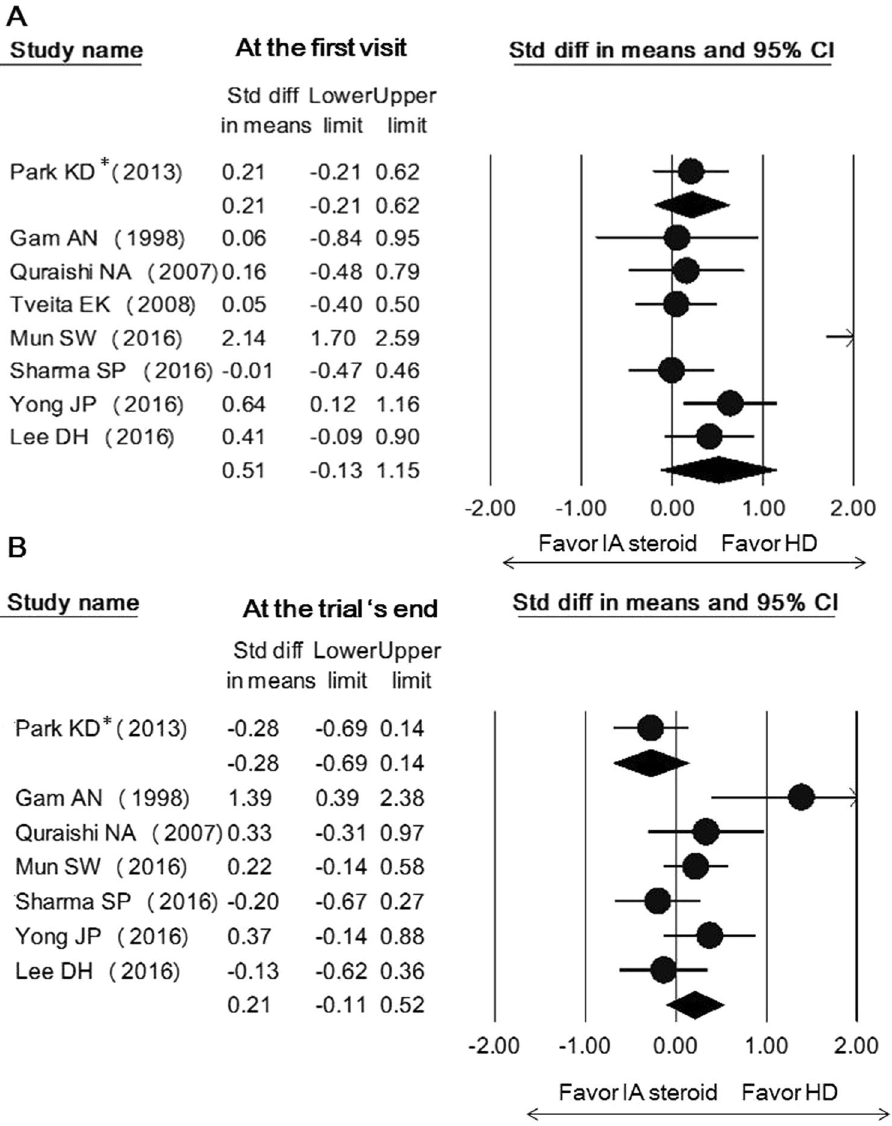
Figure 3. Forest plot of standardized mean differences of shoulder function improvement comparing hydrodilatation and intra-articular corticosteroid injection early following intervention ( A ) and at the trial’s end ( B ). Abbreviations: hydrodilatation, HD; intra-articular, IA. * denotes the regimen using hyaluronic acid instead of